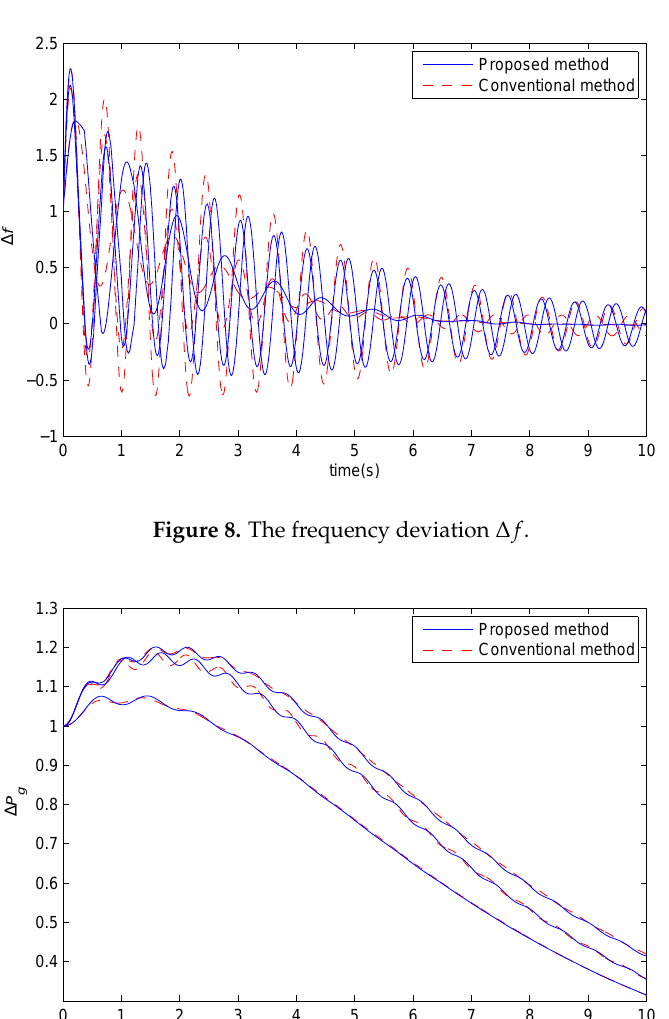
Figure 7. The output power deviation of each subsystem P out .